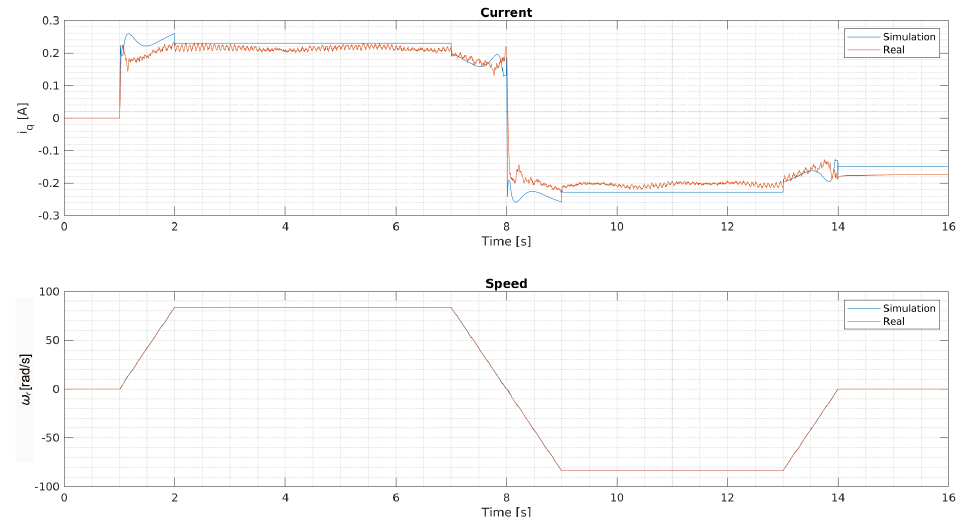
Figure 10. A comparison of the simulation and the real measurement of the actuator movement without load, with 800 rpm as the speed